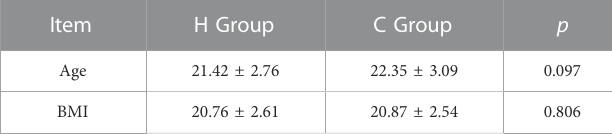
TABLE 1 Age and BMI of the two groups.